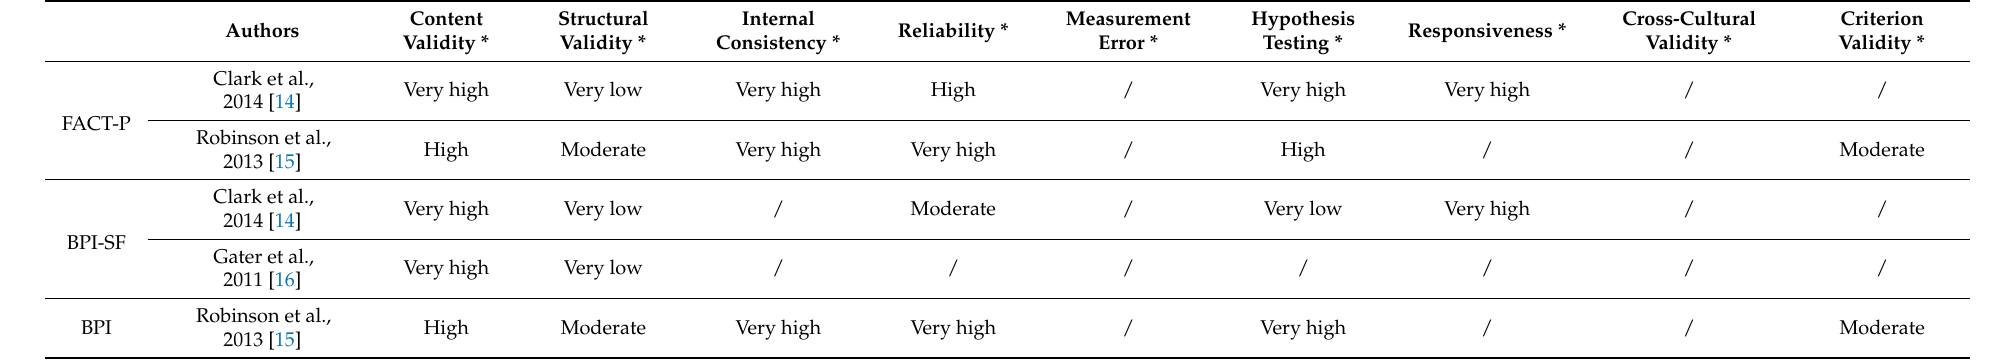
Table 4. COSMIN Checklist scores evaluating methodological quality of each study per measurement property and